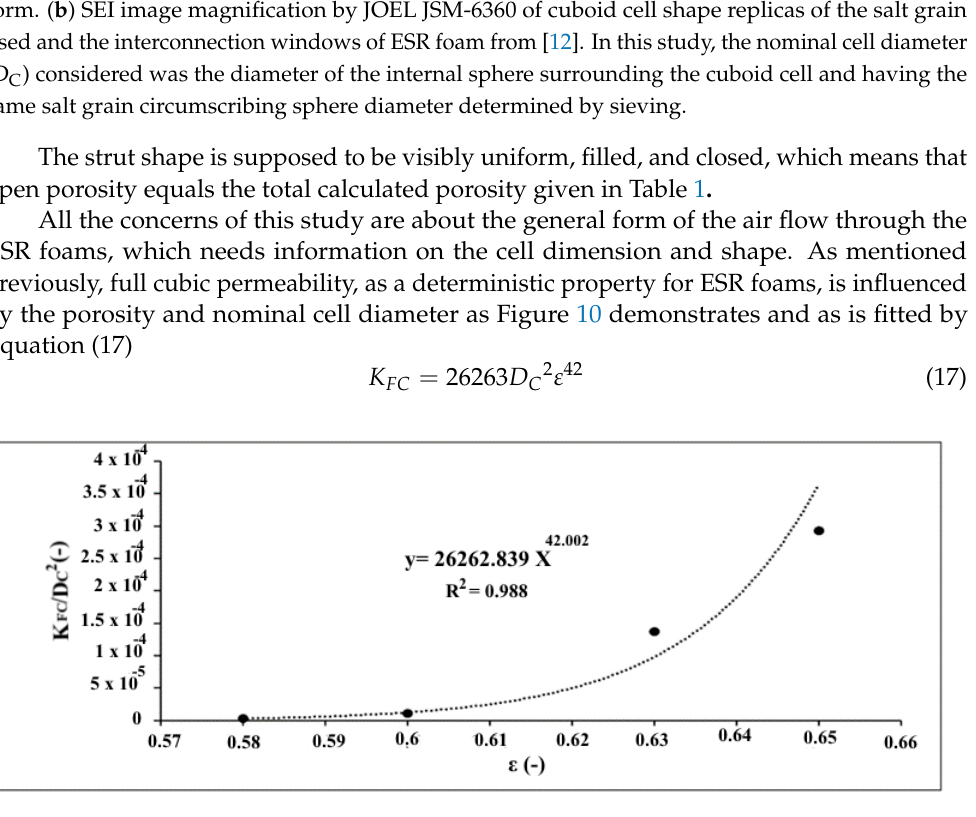
Figure 10. Description of the relationship between full cubic permeability normalised by the square cell diameter in terms of porosity of the ESR sample. cell diameter in terms of porosity of the ESR